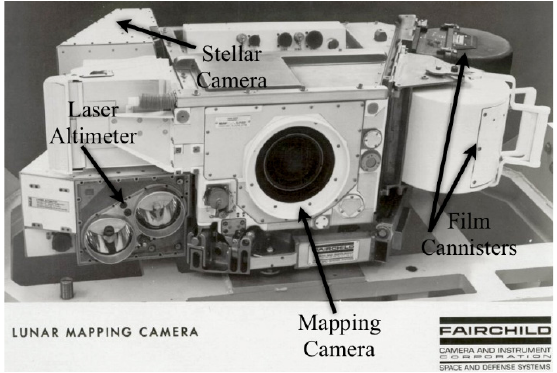
Figure 2: Apollo Lunar Mapping Camera System